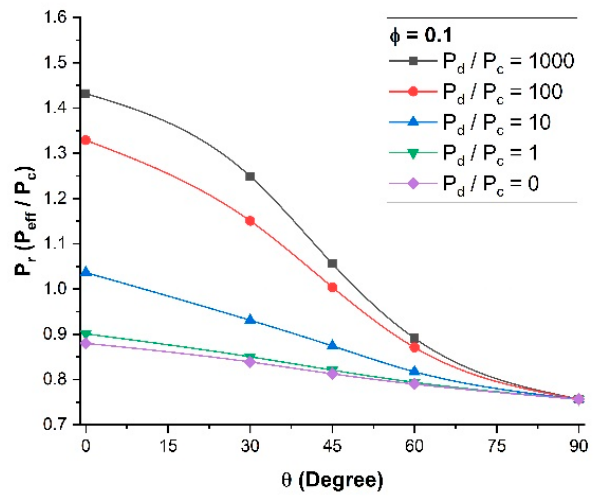
Figure 7. Relative permeability for different dispersed-to-continuous permeability ratios P d / P c at a constant volume fraction φ = 0.1 and a constant length-to-diameter aspect ratio α = 10.